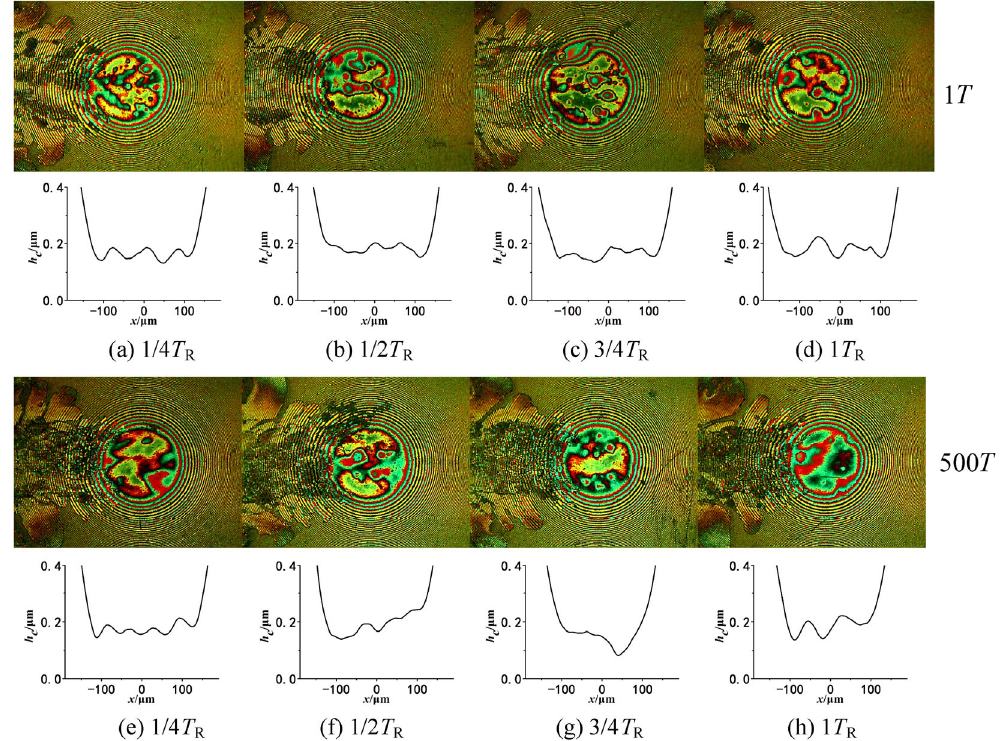
Fig. 3 Interferograms and midsection film thickness during 1st and 500th cycle under pure rolling steady-state motion ( v e = 0.01 m/s, w = 15